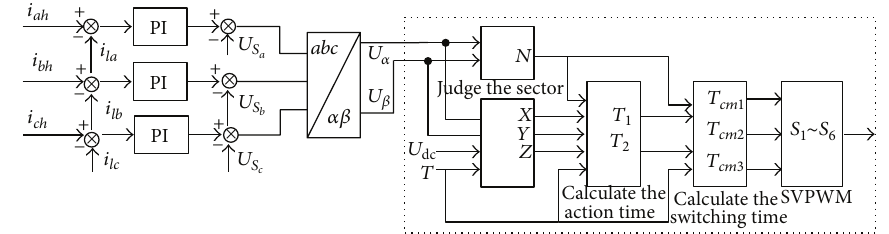
Figure 5: Control diagram of the SVPWM.